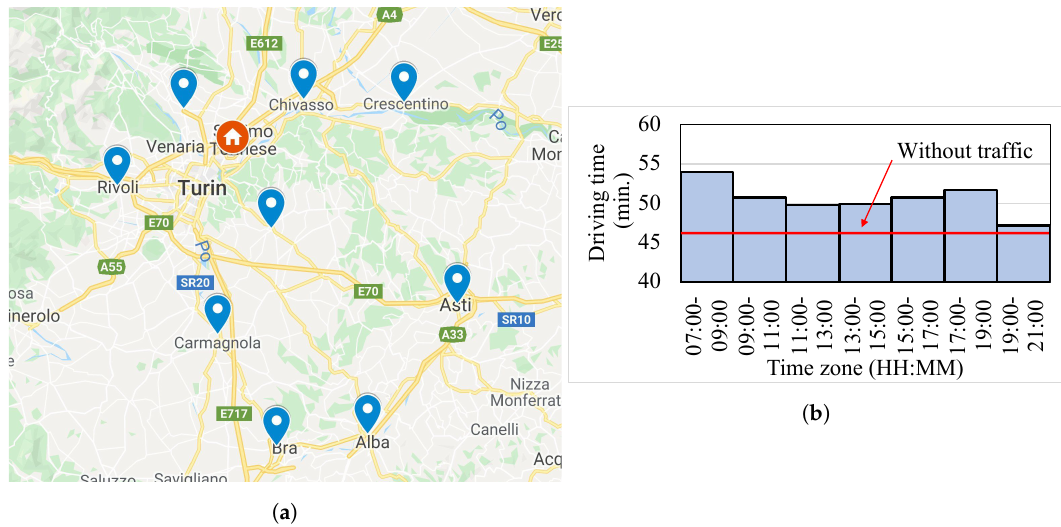
Figure 9. Delivery problem on real roads: ( a ) destinations for deliveries and ( b ) average driving time for moving between